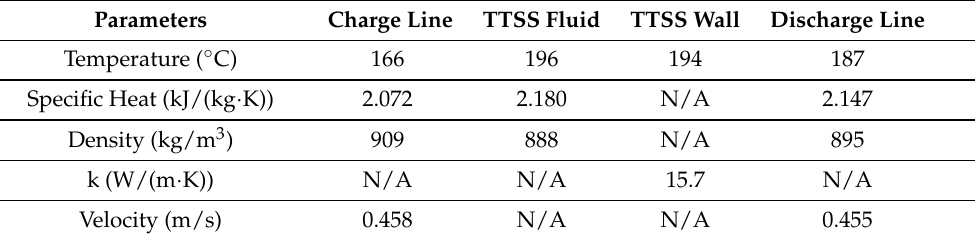
Table 2. Nominal values to non-dimensionalize the generated data. N/A indicates that the value was either not measured or not